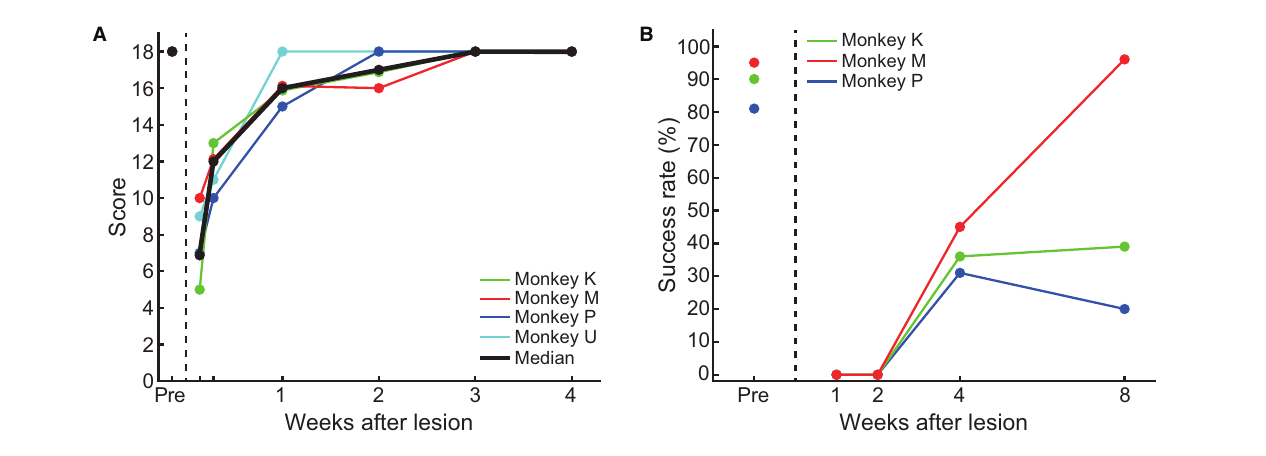
FIGURE4 Time course of behavioral recovery. (A) Transitional changes in the marmoset neurological score. The black line represents the median value at each time point. (B) Transitional changes in the success rate of the pellet-reaching task.